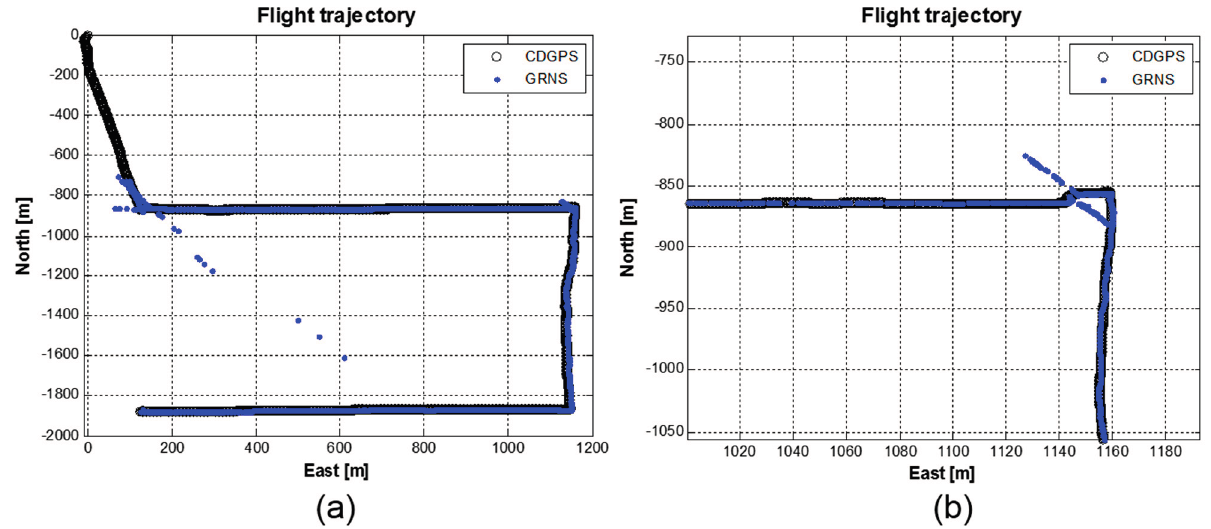
Figure 14. 2D trajectory: ( a ) Full trajectory; ( b ) Zoom-in figure of the upper right corner of ( a